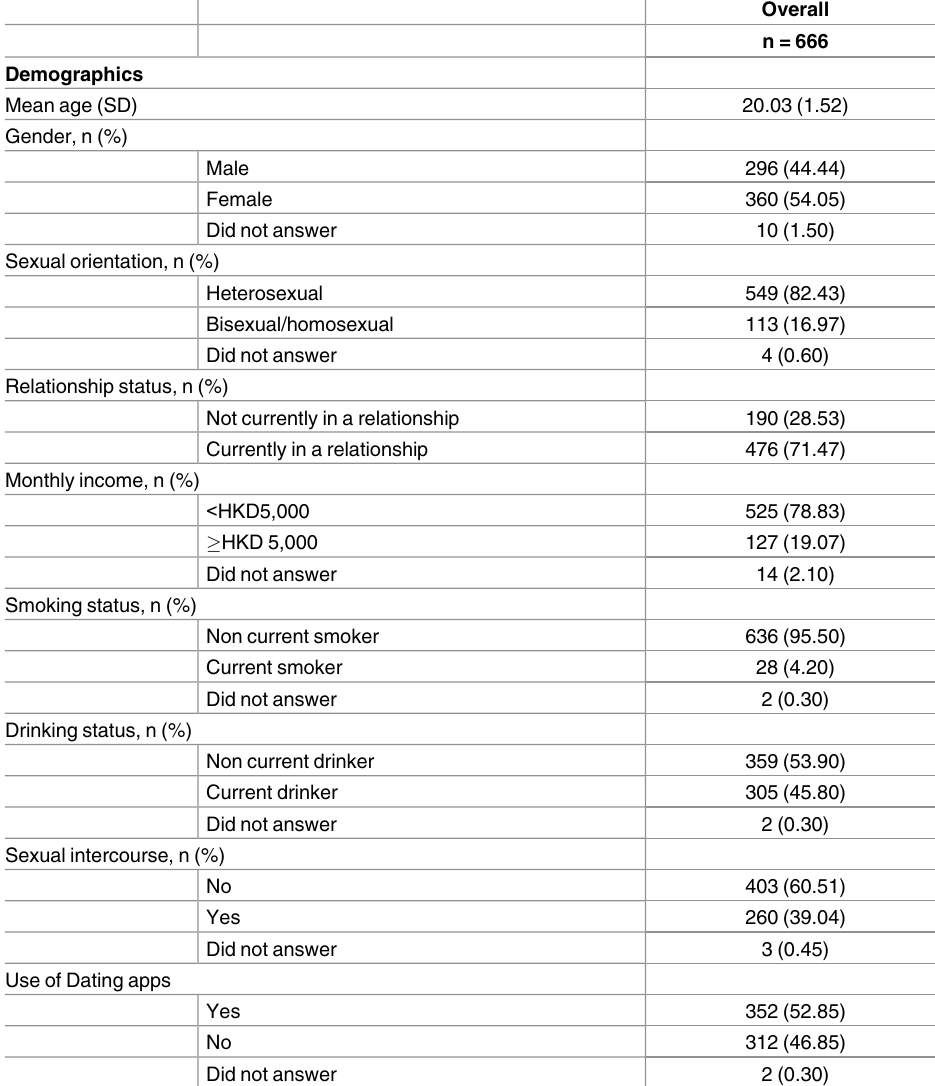
Table 1. Demographic information of